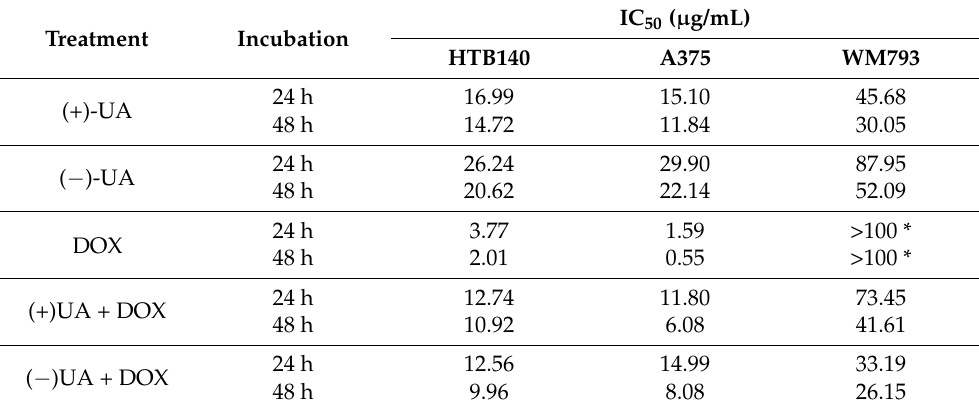
Table 1. Concentrations of (+)- and ( − )-usnic acid (UA) and doxorubicin (DOX) alone or in combina- tions, that induced 50% decrease in cell viability after 24 h and 48 h of treatment.